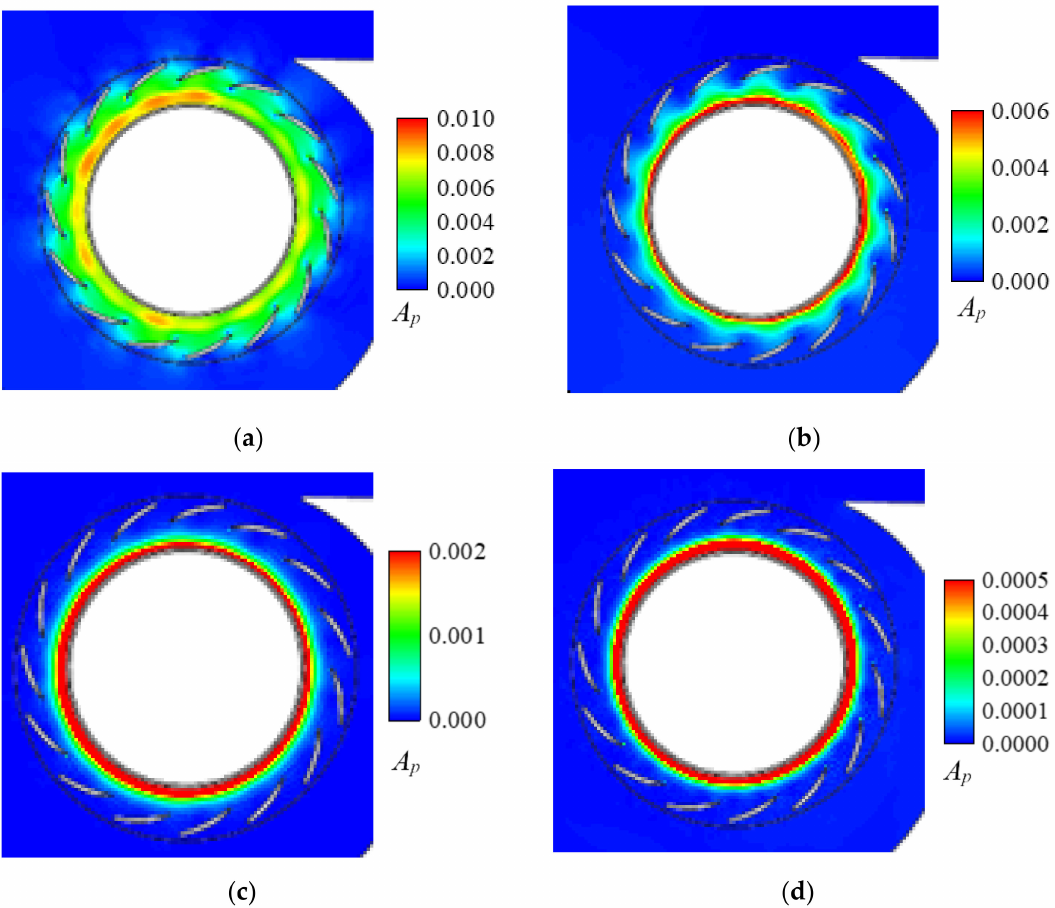
Figure 14. A p amplitude contour of typical frequencies on the Z = 0 plane. ( a ) 140 Hz; ( b ) 280 Hz; ( c ) 420 Hz; ( d ) 560